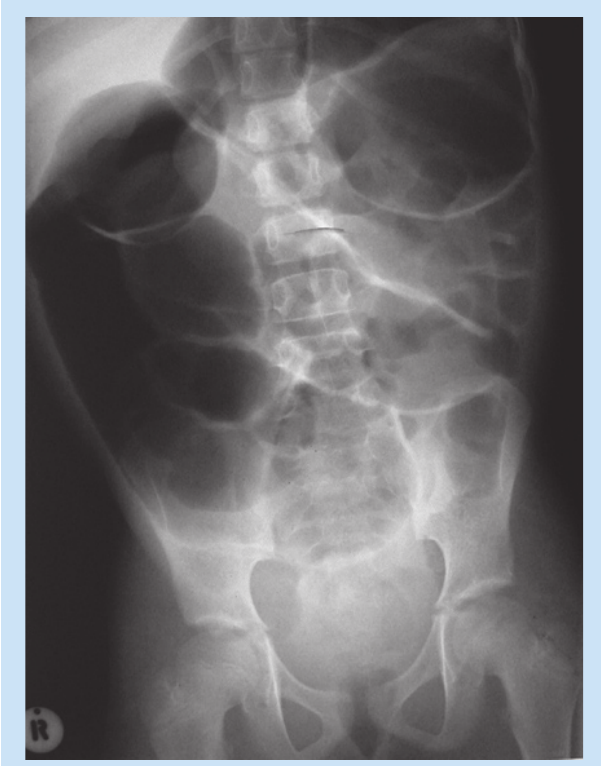
Fig. 2. Abdominal X-ray of 9-year-old Sotho girl.